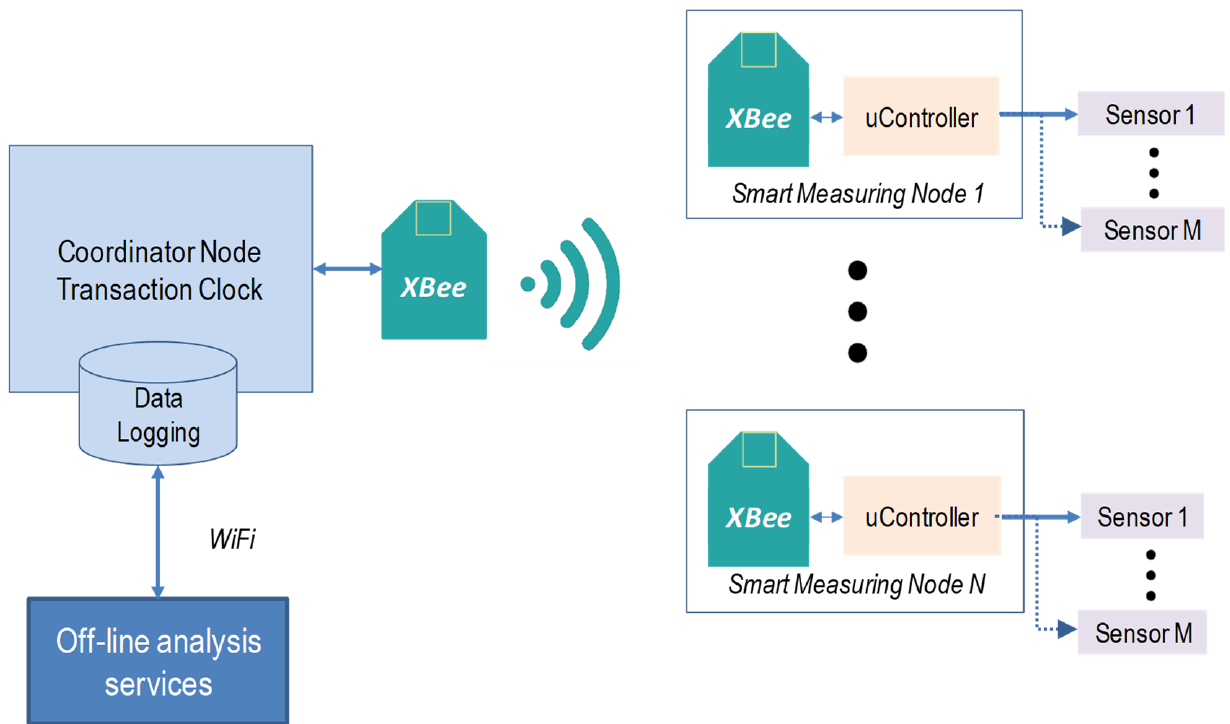
Figure 1. General architecture overview for the wireless monitoring system.